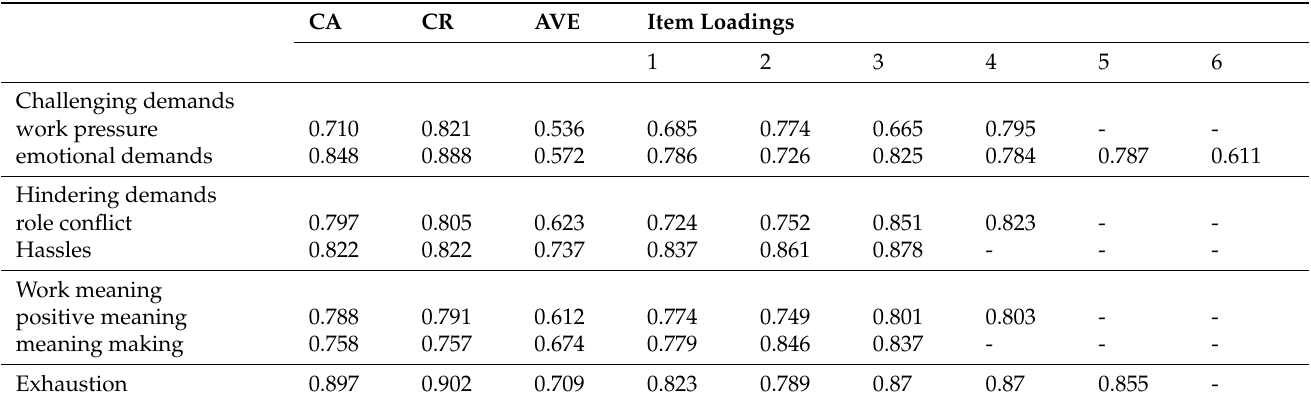
Table 2. Assessment of reflective constructs.